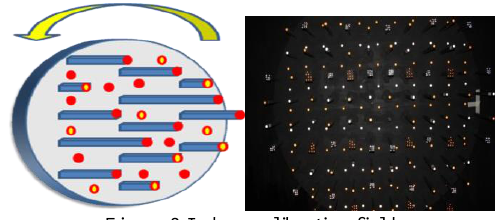
Figure 8 Indoor calibration field